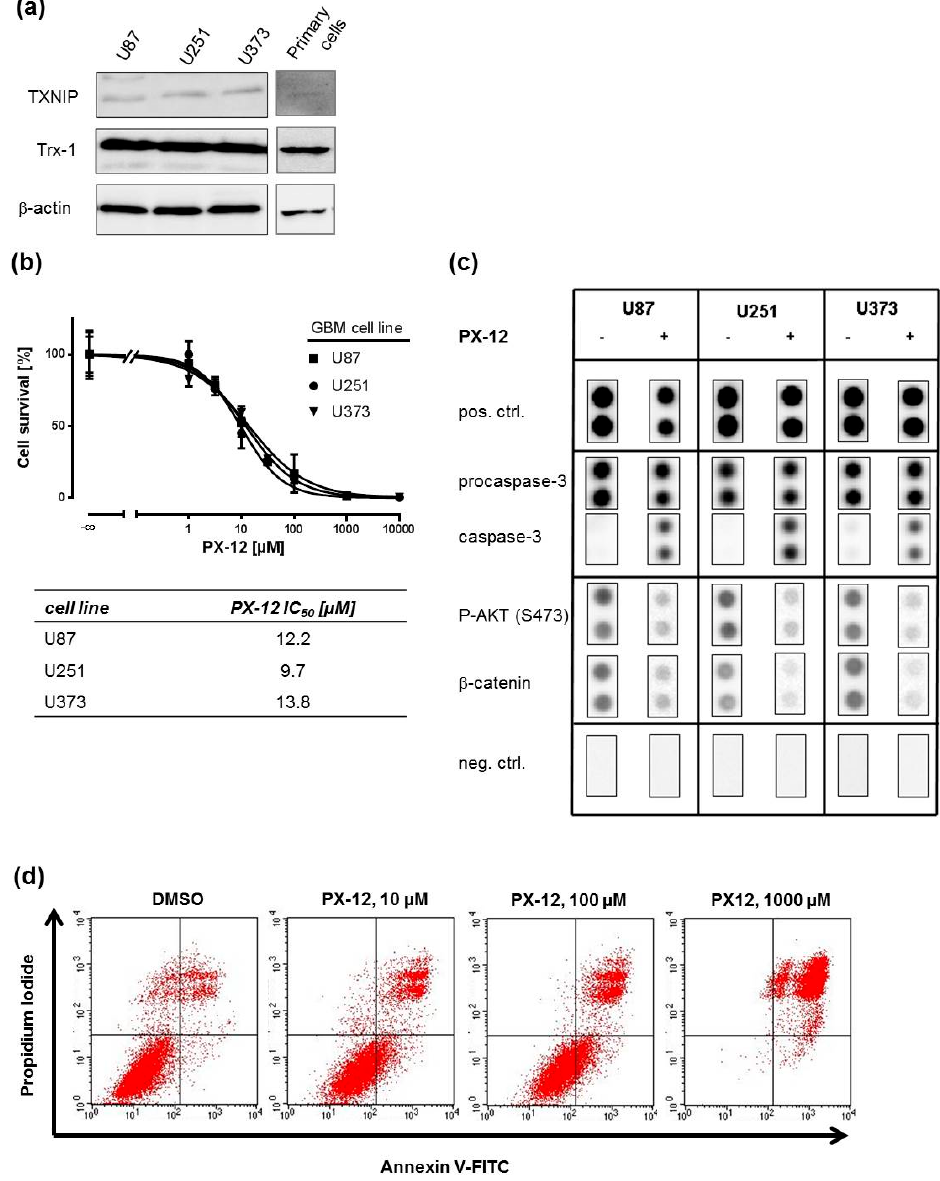
Figure 1. Pharmacological inhibition of thioredoxin (Trx) increases cell death via induction of apoptosis in human glioblastoma multiforme (GBM) cell lines. ( a ) Representative Western blots showing endogenous Trx-1 and Trx-interacting protein (TXNIP) expression in U87, U251, U373, and primary GBM cells. β -actin Western blot was performed to control for loading; ( b ) 3-(4,5-dimethylthiazol-2-yl)-2,5-diphenyltetrazolium bromide (MTT) concentration-response curves after 1-methyl-2-imidazolyl-disulfide (PX-12) exposure for 72 h in U87, U251, and U373 cells (upper graph). Respective PX-12 IC 50 values are displayed in the table below the graph ( n = 4); ( c ) Human proteome-profiler antibody arrays were used to assess the expression/phosphorylation of AKT (S473), procaspase-3, caspase-3, and β -catenin 72 h after PX-12 exposure; ( d ) Representative FACS blots of U251 cells treated with either vehicle (DMSO) or increasing PX-12 concentrations for 72 h as indicated. Annexin V positive cells were regarded as apoptotic cells.